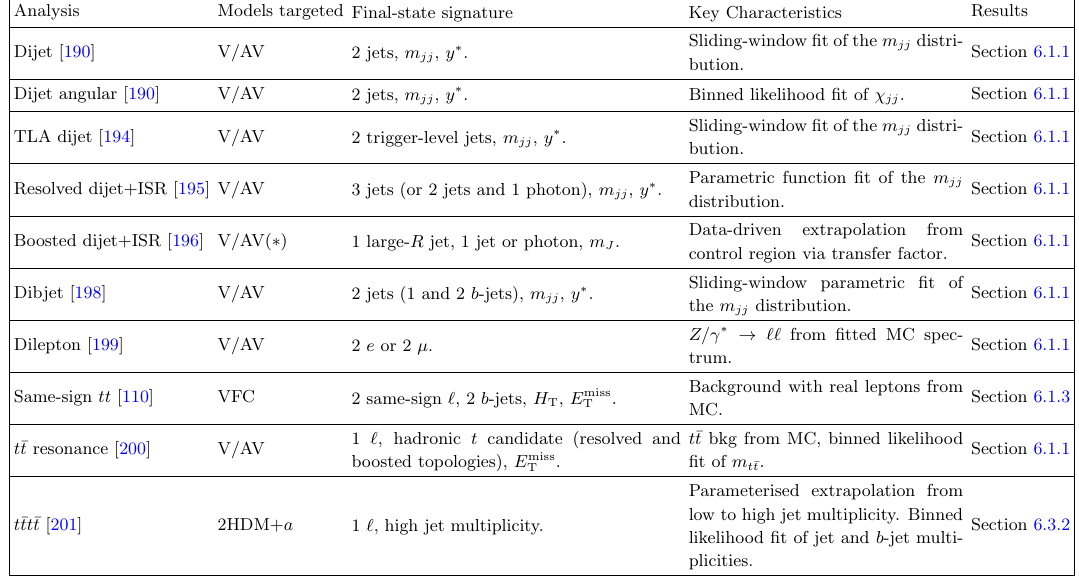
Table 3. Summary of searches for visible (cid:12)nal states used to constrain the di(cid:11)erent DM models de(cid:12)ned in section 2. The ( ) indicates models which were presented in the original publication, all (cid:3) others are either new or